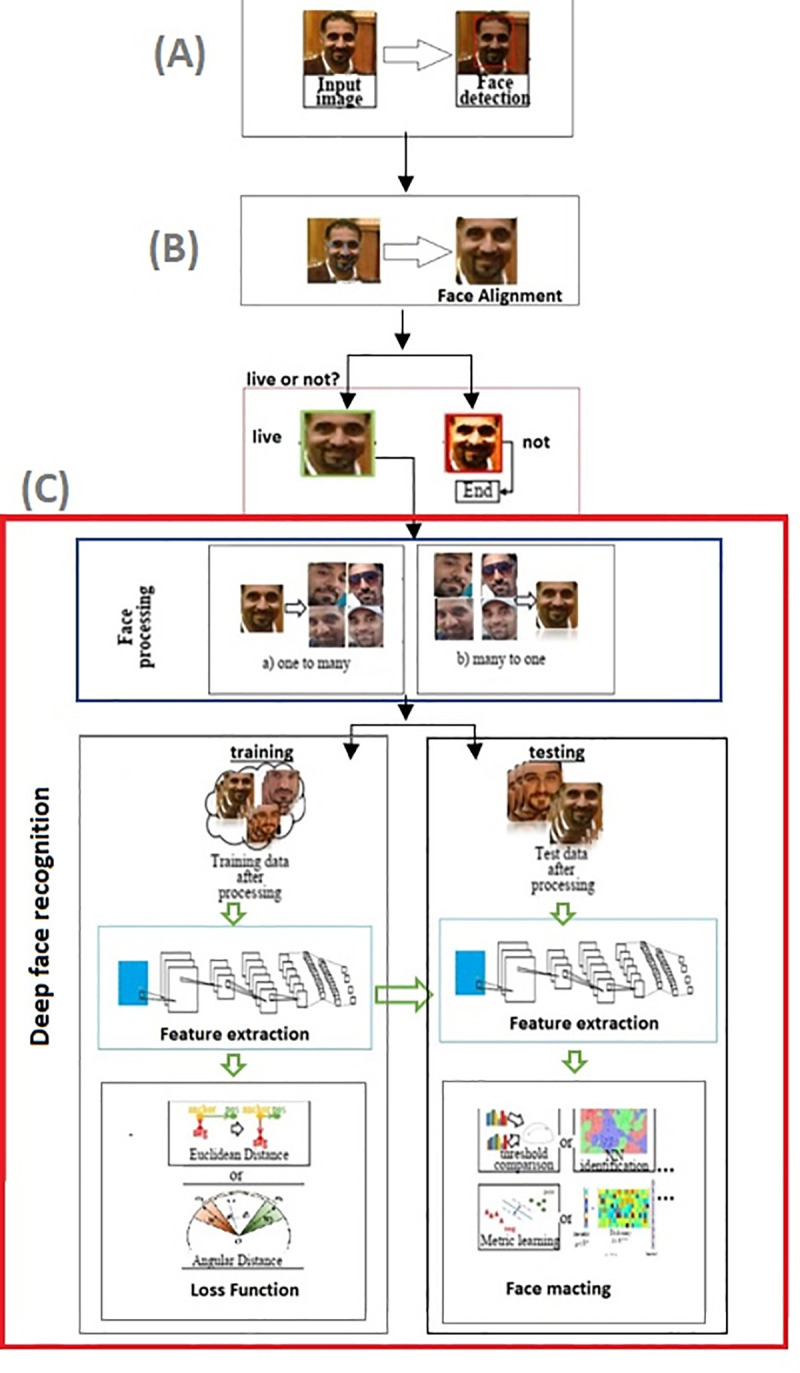
Deep FR system with face detector and alignment.